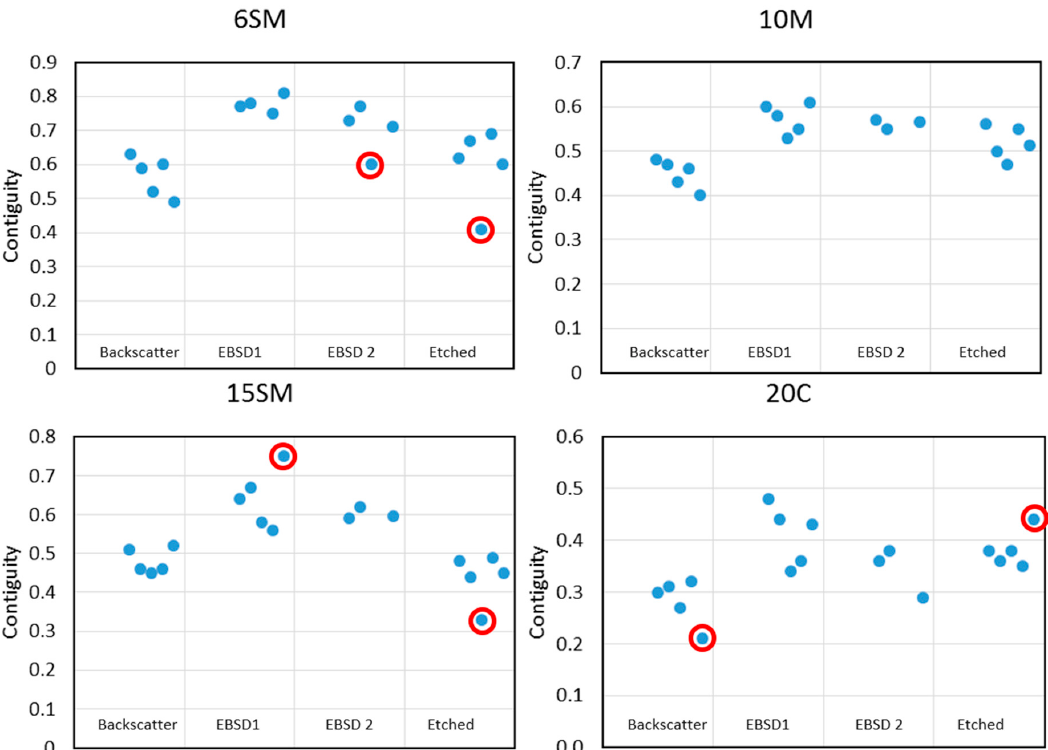
Figure 3. Individual graphs of contiguity measurements for each grade. Results that differ by more than one standard deviation from the mean of each set (image type and grade) ringed in red (note scales are not identical on Y axes).